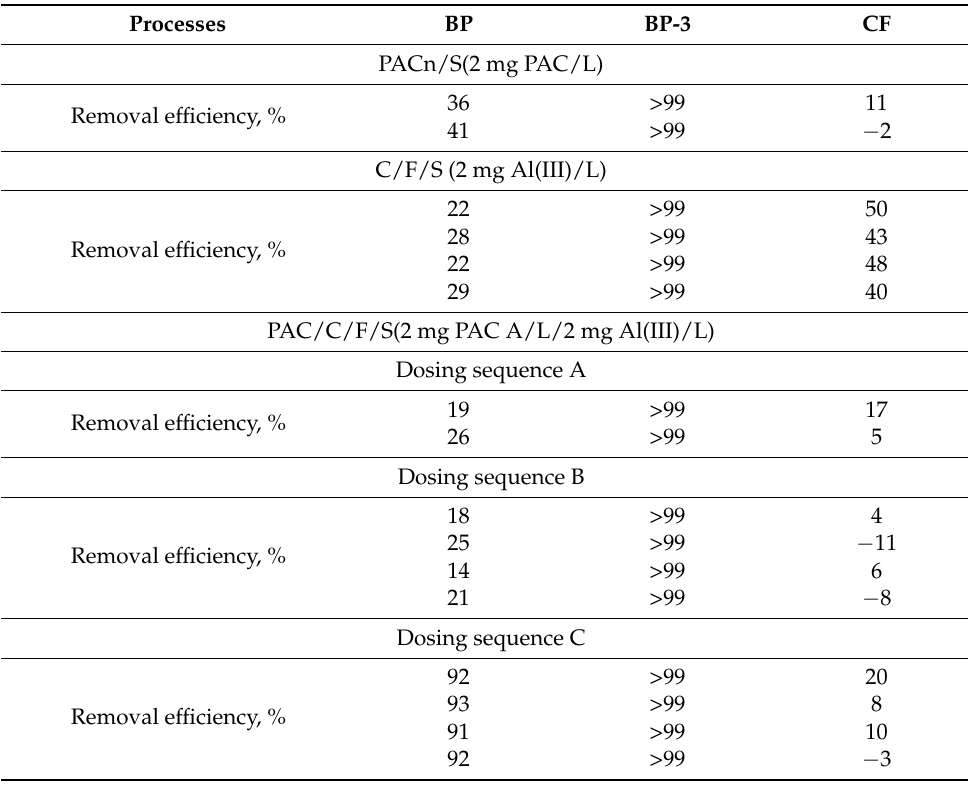
Table 6. Removal efficiency of BP, BP-3 and CF by PAC/S, C/F/S and combined